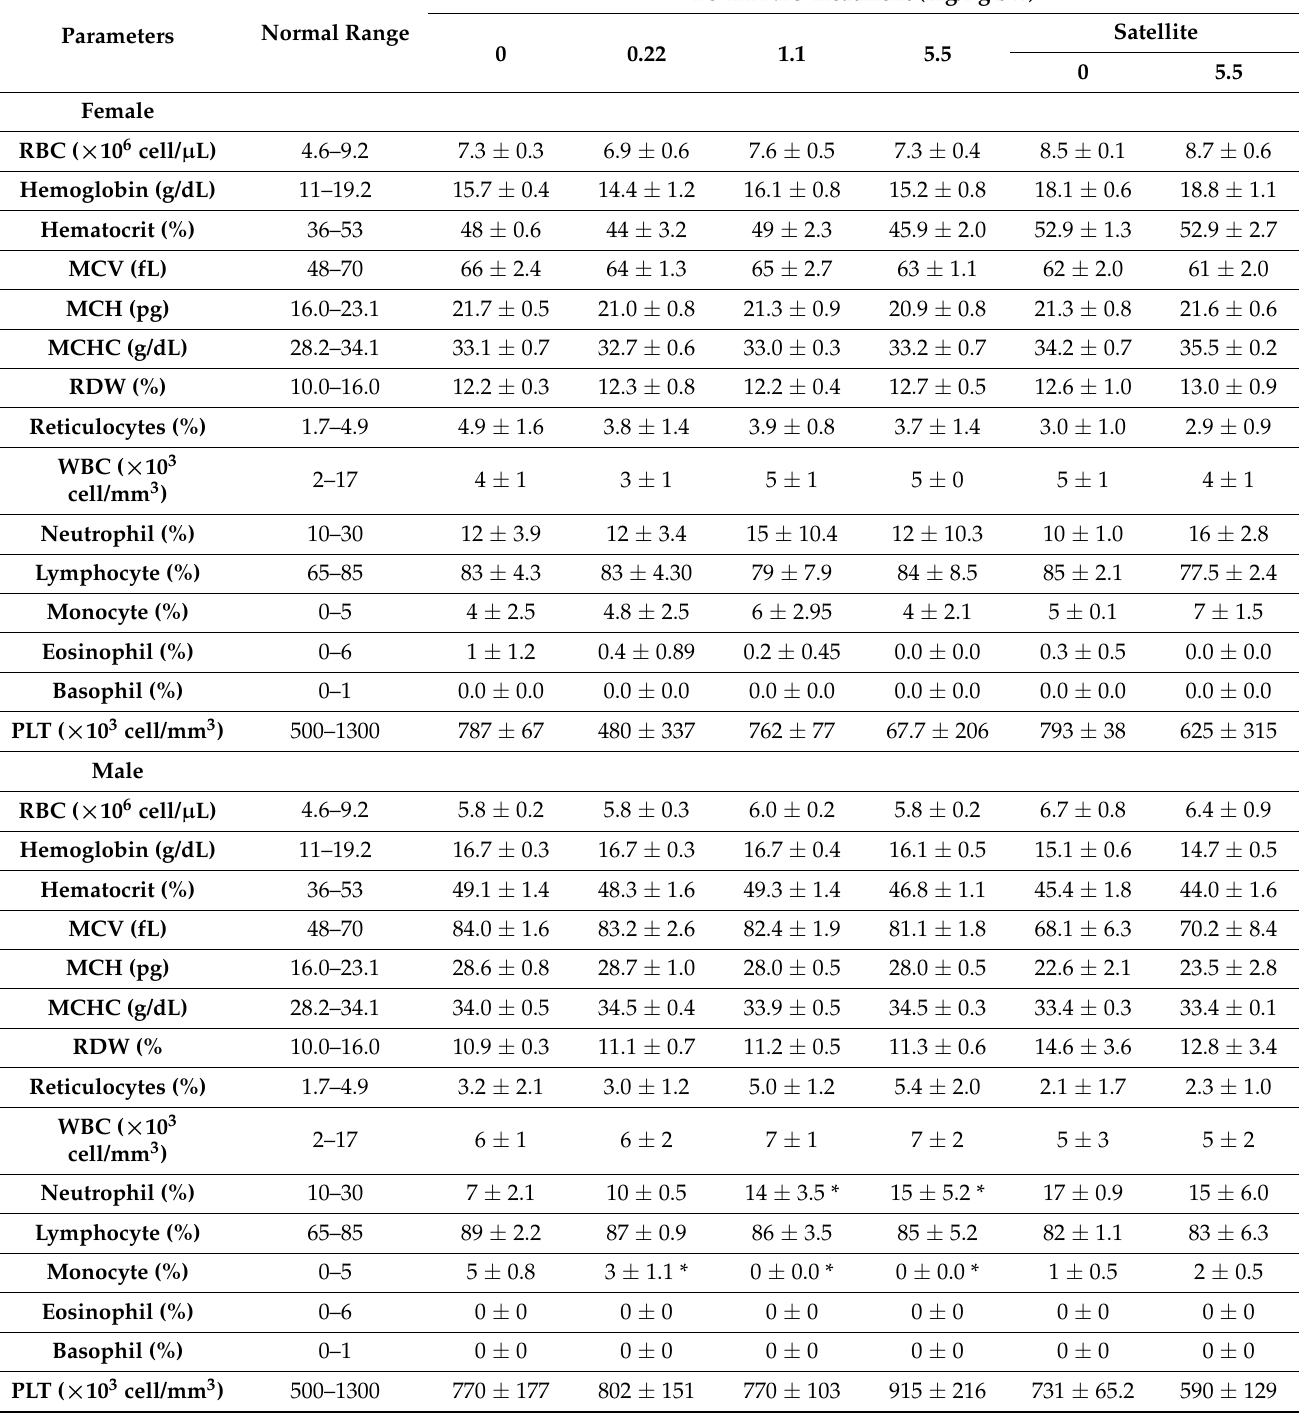
Table 2. Effect of Fe-TA NPs on hematological profile in rats exposed to repeated dose toxicity